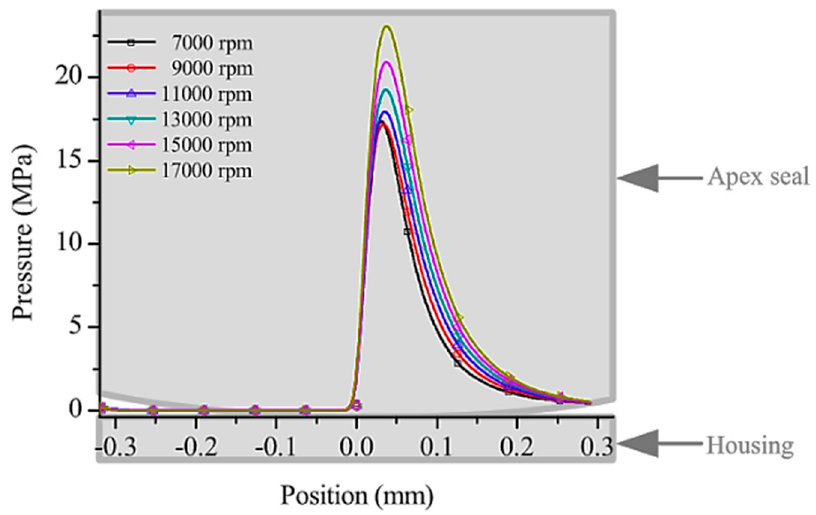
Figure 9. Pressure distribution at various engine speeds (Zhang et al. [78]).